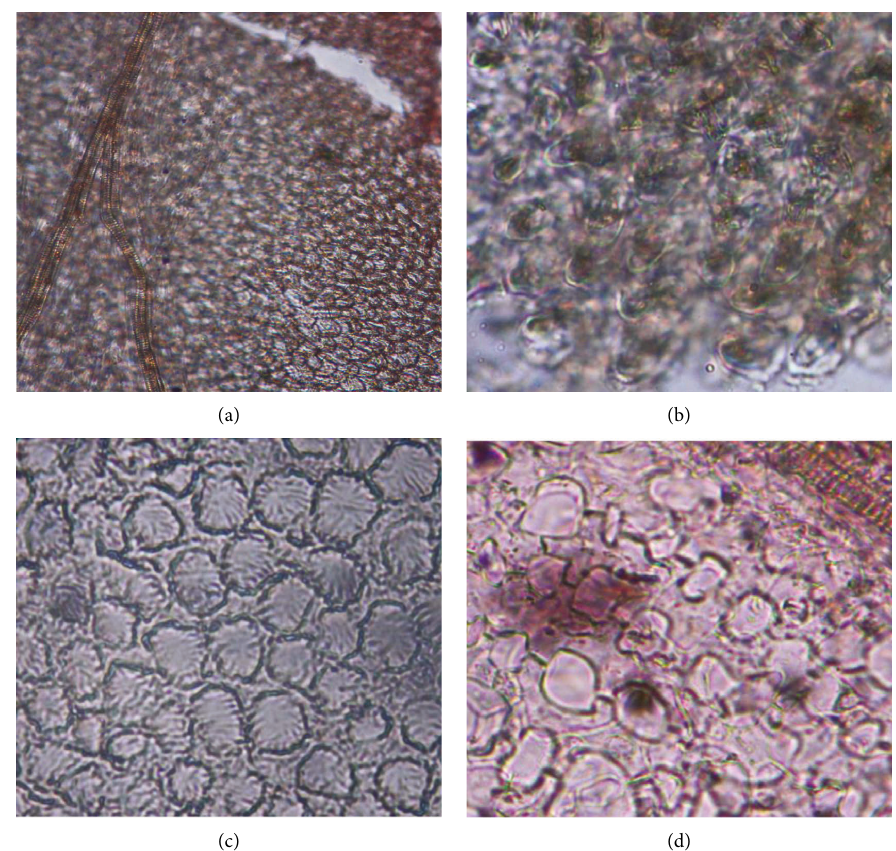
Figure 2: Microscopic characteristics of R. damascena flower petals and petals from buds: (a) parenchyma with vessels (magn. × 100); (b) adaxial surface (magn. × 400); (c) abaxial surface (magn. × 400); (d) spongy parenchyma (magn. ×